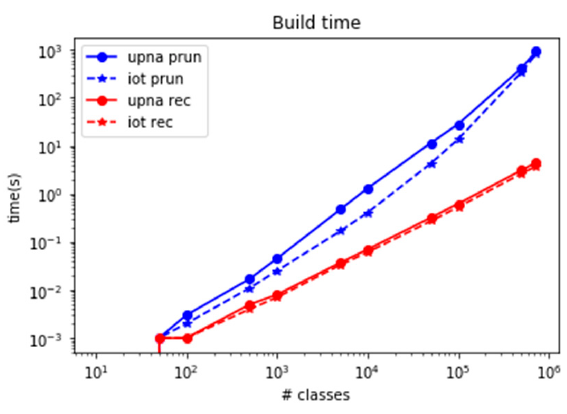
Figure 16. Comparison of memory usage.